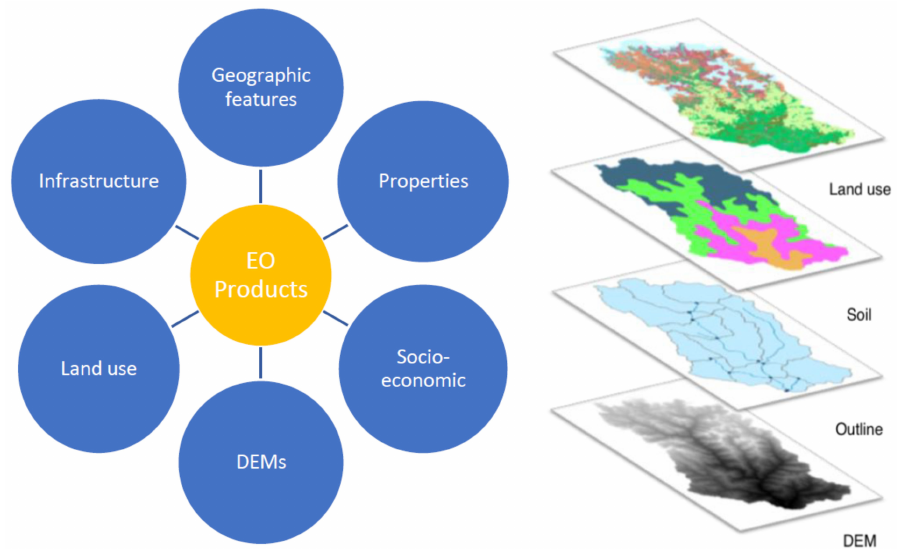
Figure 3. Different remote sensing data necessary for risk assessment ( left ) and thematic layers used to store the specific spatial information in the GIS database (e.g., Dudh Koshi River basin in Nepal) ( right